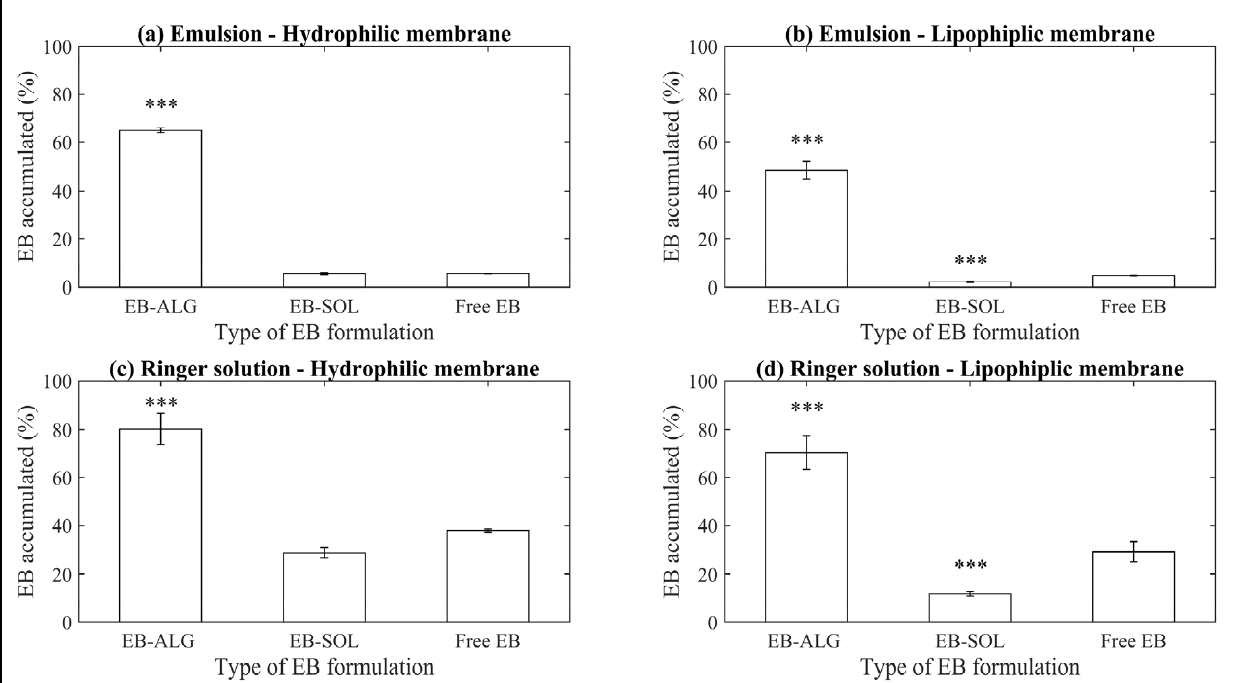
Figure 2. Accumulated dissolution/permeation (%) of EB using synthetic membranes. ( a ) Represents the emulsion as donor media with the hydrophilic membrane (EM–H); ( b ) represents the emulsion as donor media with the lipophilic membrane (EM–L); ( c ) represents the Ringer solution as donor media with the hydrophilic membrane (RS–H); and ( d ) represents the Ringer solution as donor media with the lipophilic membrane (RS–L). Values represent the mean with standard deviation, n = 3, with an initial concentration of microparticles of 0.53 mg/mL for emulsion, and 0.56 mg/mL for Ringer solution. p < 0.001 (***)was taken to be statistically different compared to free EB (control), calculated by a t-student test.